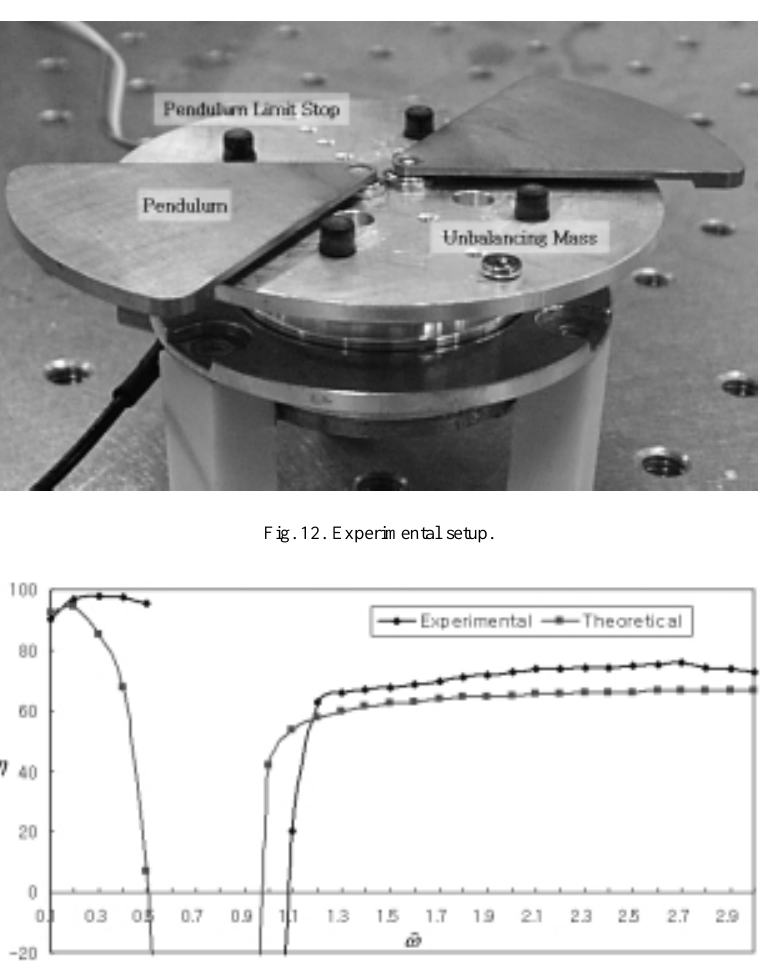
Fig. 13. Vibration reduction